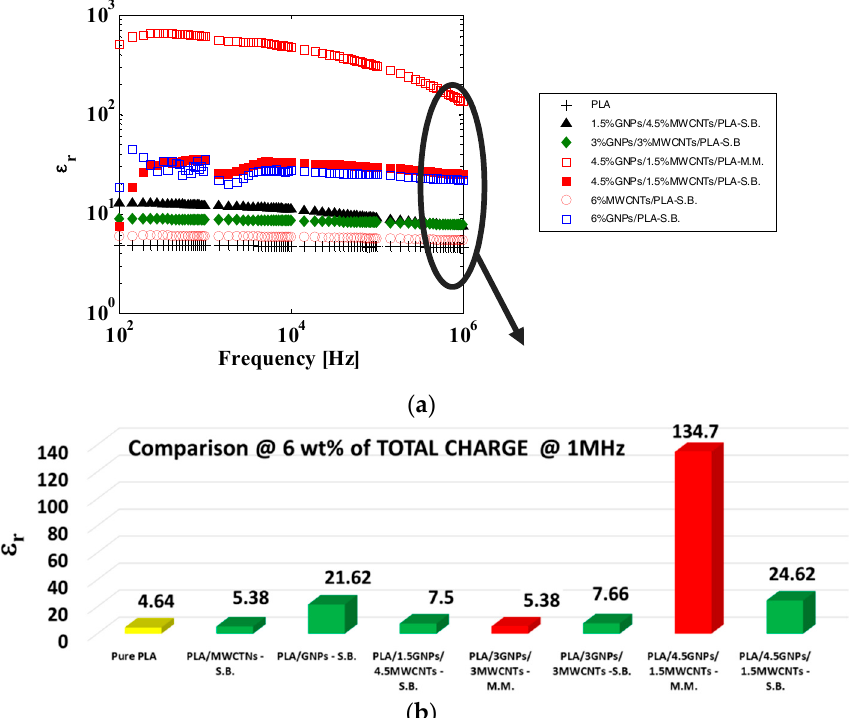
Figure 8. ( a ) Real part of the complex permittivity in the frequency range of 100 Hz–1 MHz; ( b ) comparison of specimens at 6 wt % of total charge evaluated at the frequency of 1 MHz. Some formulations are not reported because they are outside the measurability range of the instrument (saturation limit of 150 mA).